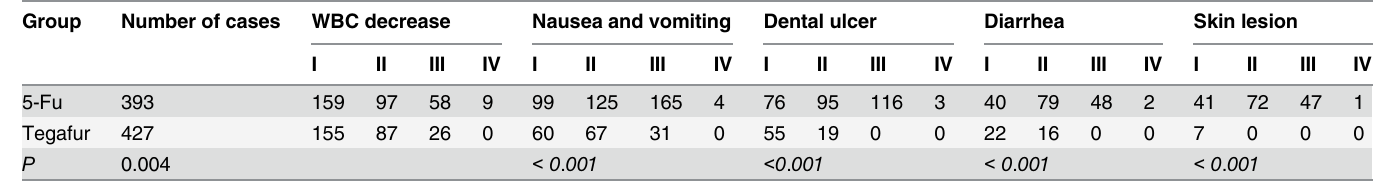
Table 4. Comparison of the side effects between the tegafur and 5-Fu groups. Group Number of